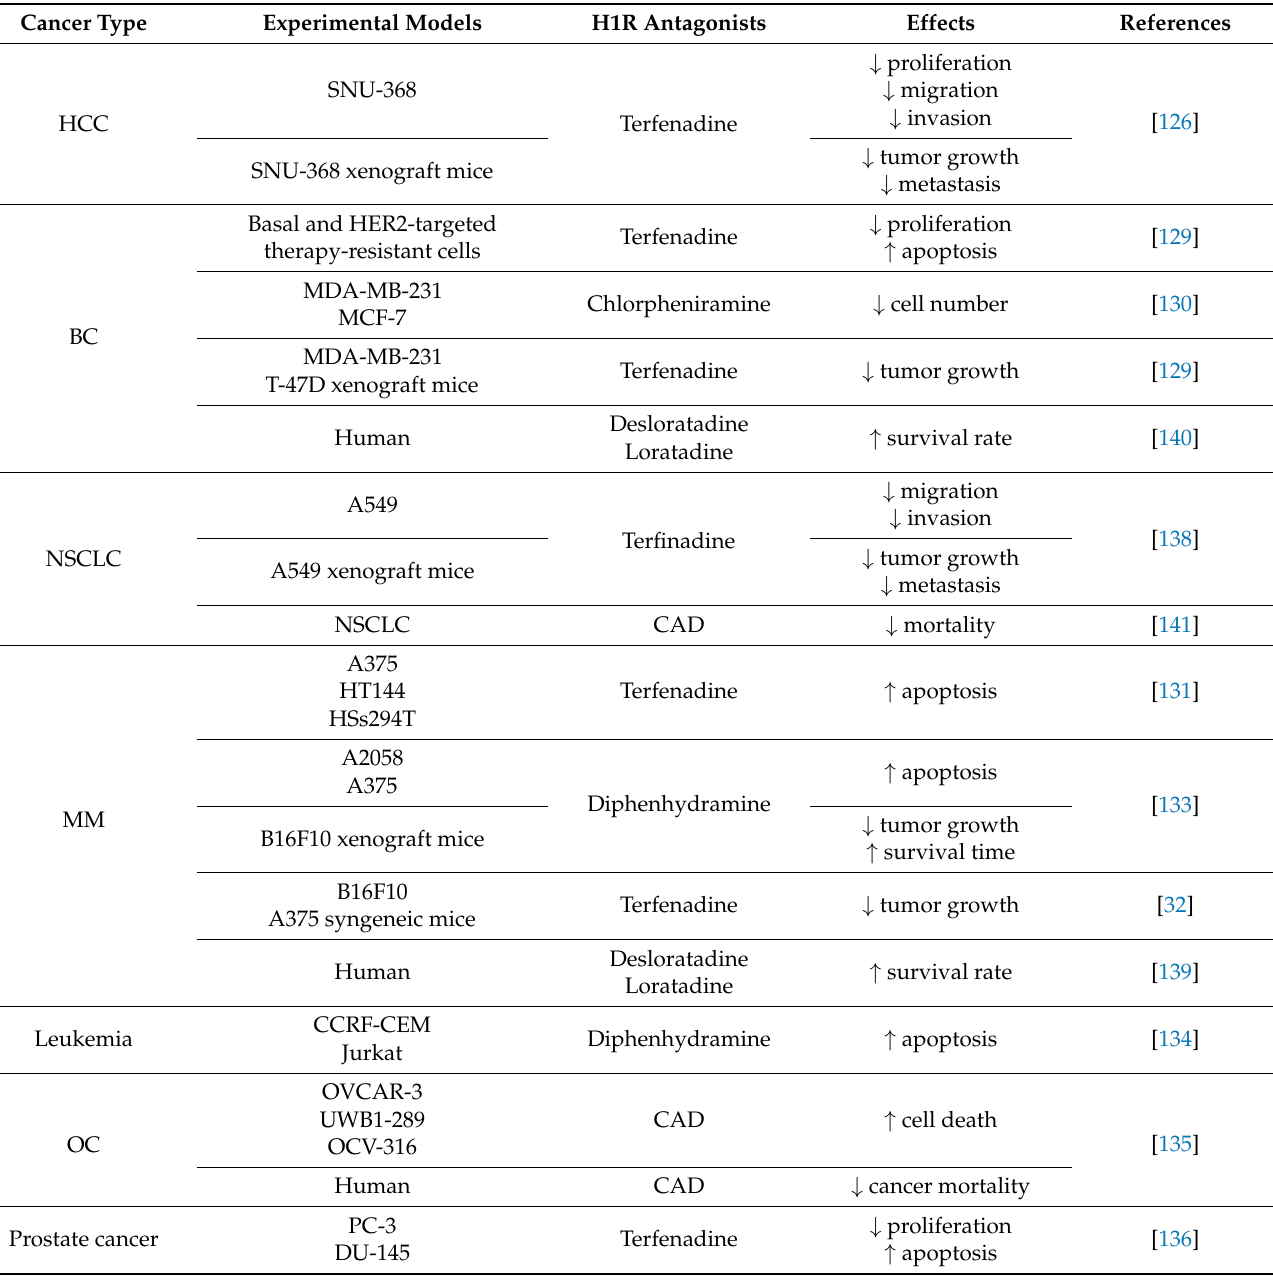
Table 2. In vitro and in vivo effects of H1R antagonists on tumor progression in different cancer types. Cancer